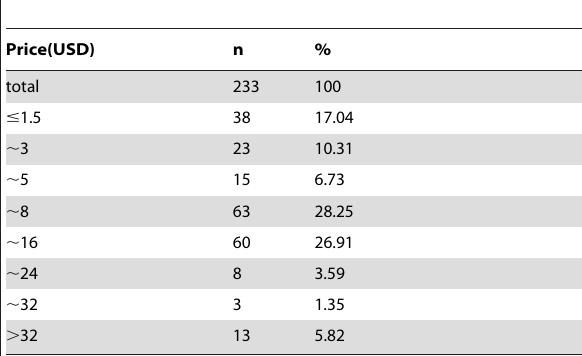
Table 4. Maximum amount willing to pay for the oral fluid HIV rapid test (RMB:USD